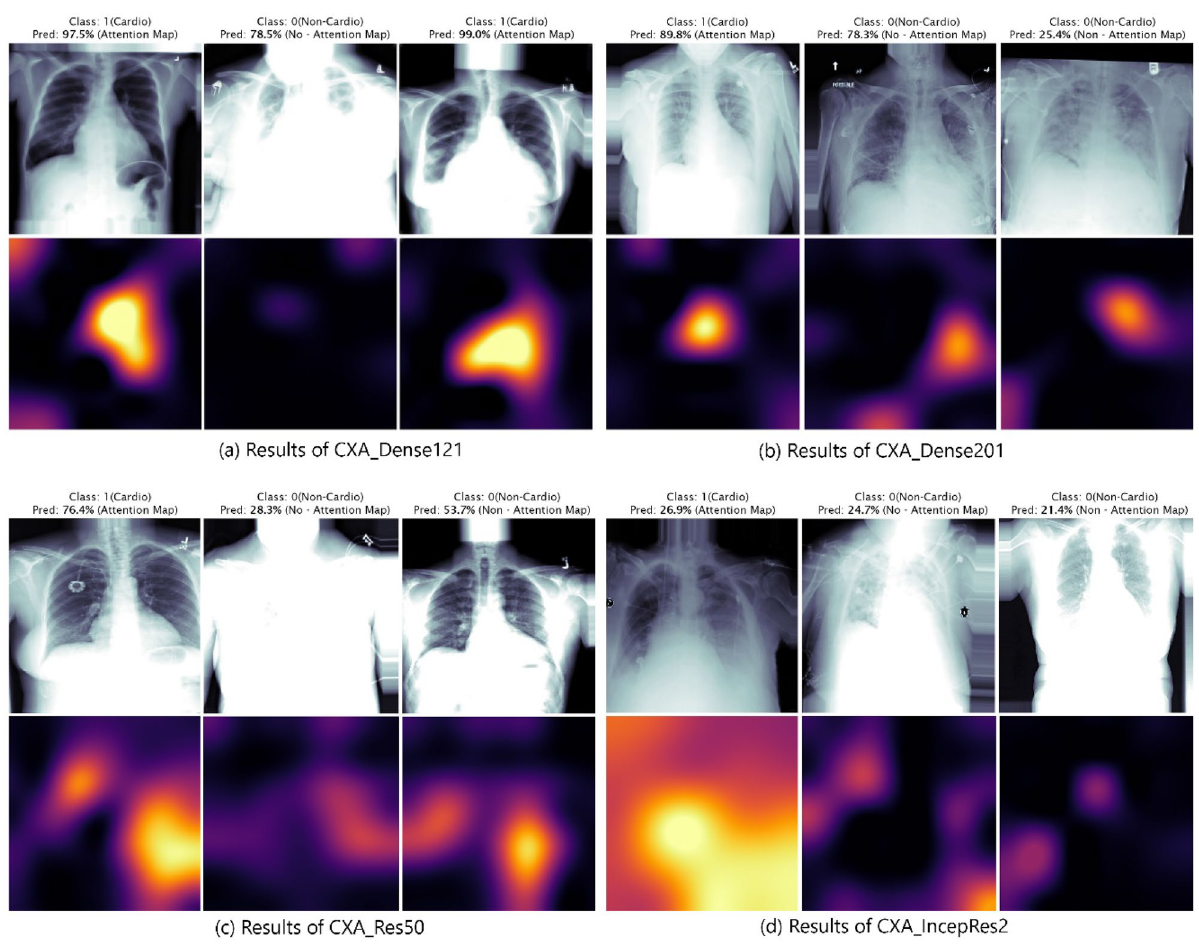
Figure 7. The results from attention map CXA_Dense121, CXA_Dense201, CXA_Res50 and CXA_IncepRes2 are shown in above ( a ), ( b ), ( c ) and ( d ) respectively. The ground truth of Class: 0 for Non-Cardiomegaly and 1 for Cardiomegaly are set. CXA_Dense121 model produces strong results compare to others for classifying cardiomegaly class information and localization on the most indicative area on the chest x-ray image.